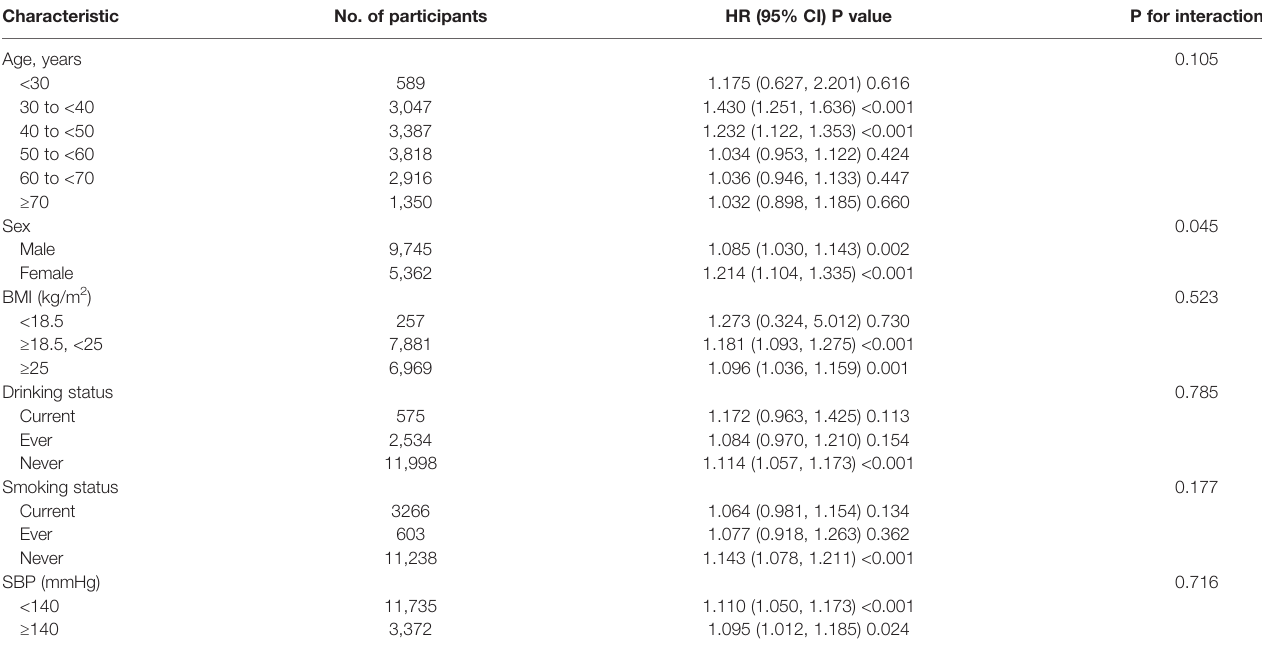
TABLE 7 | Strati fi ed associations between TG/HDL-c ratio and diabetes in participants with prediabetes by age, sex, BMI, SBP, smoking status, and drinking status. Characteristic